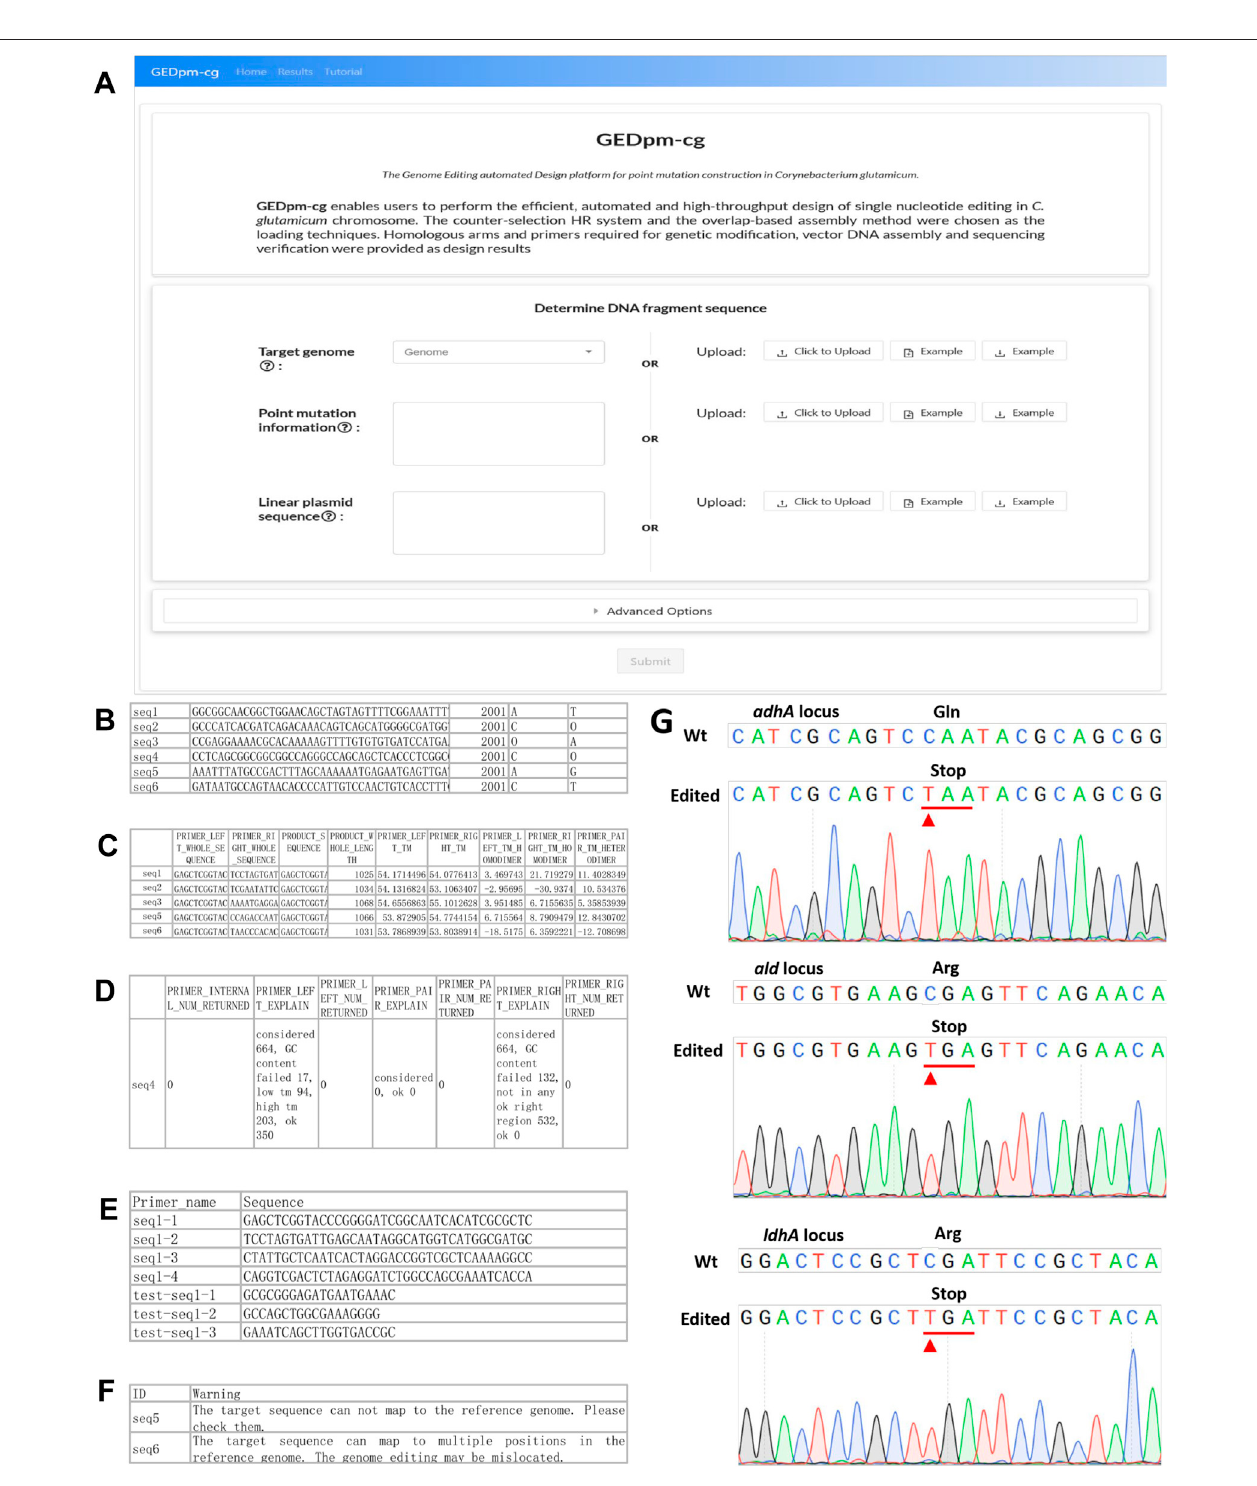
FIGURE 4 | GEDpm-cg web-based interface and examples for input, output and experimental veri fi cation. (A) . GEDpm-cg web-based interface. (B) . Example parts list CSV input fi le for targeted sequences. (C) . Example primer-1 and primer-2, list in XLSX output fi le. (D) . Example primers submitted to the sequence synthesis company, list in XLSX output fi le. (E) . Example of failed primer designs for UHA, list in XLSX output fi le. (F) . Example of possible mis-matching sequences, list in XLSX output fi le. (G) . Sanger sequencing results of point mutation genome editing for adhA C568T , ald C973T and ldhA C463T . The substituted bases are marked with red